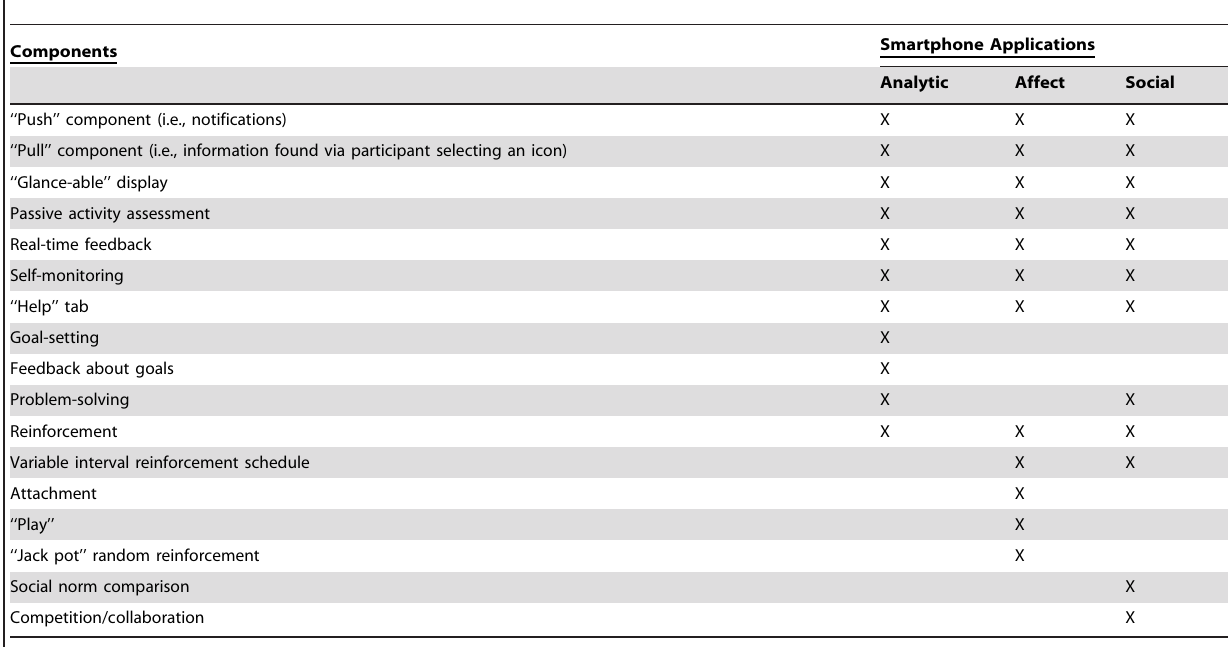
Table 1. Behavioral Components for the Analytic, Affect, and Social Applications.